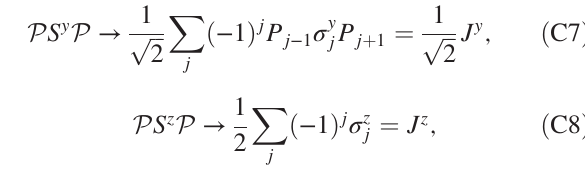
FIG. 8. Fidelity and period of revivals for two eigenstates of S z projected into the PXP Hilbert space and evolved with H with λ ¼ 0 . 051 . For j S j ¼ N= 2 − 1 the revivals get better as system size is increased, and are expected to match up with those of j S j ¼ N= 2 in the thermodynamic limit.